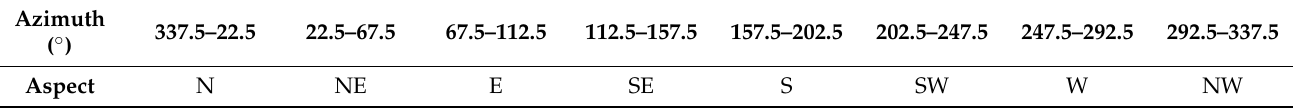
Table 3. Classification of slope aspect in this study.